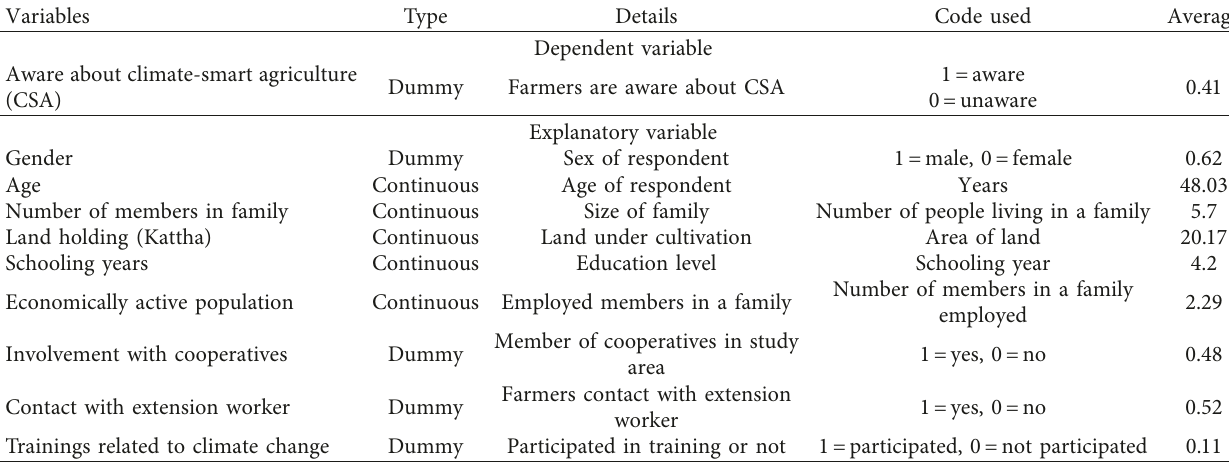
Table 1: Details of parameters used in the binary logit regression